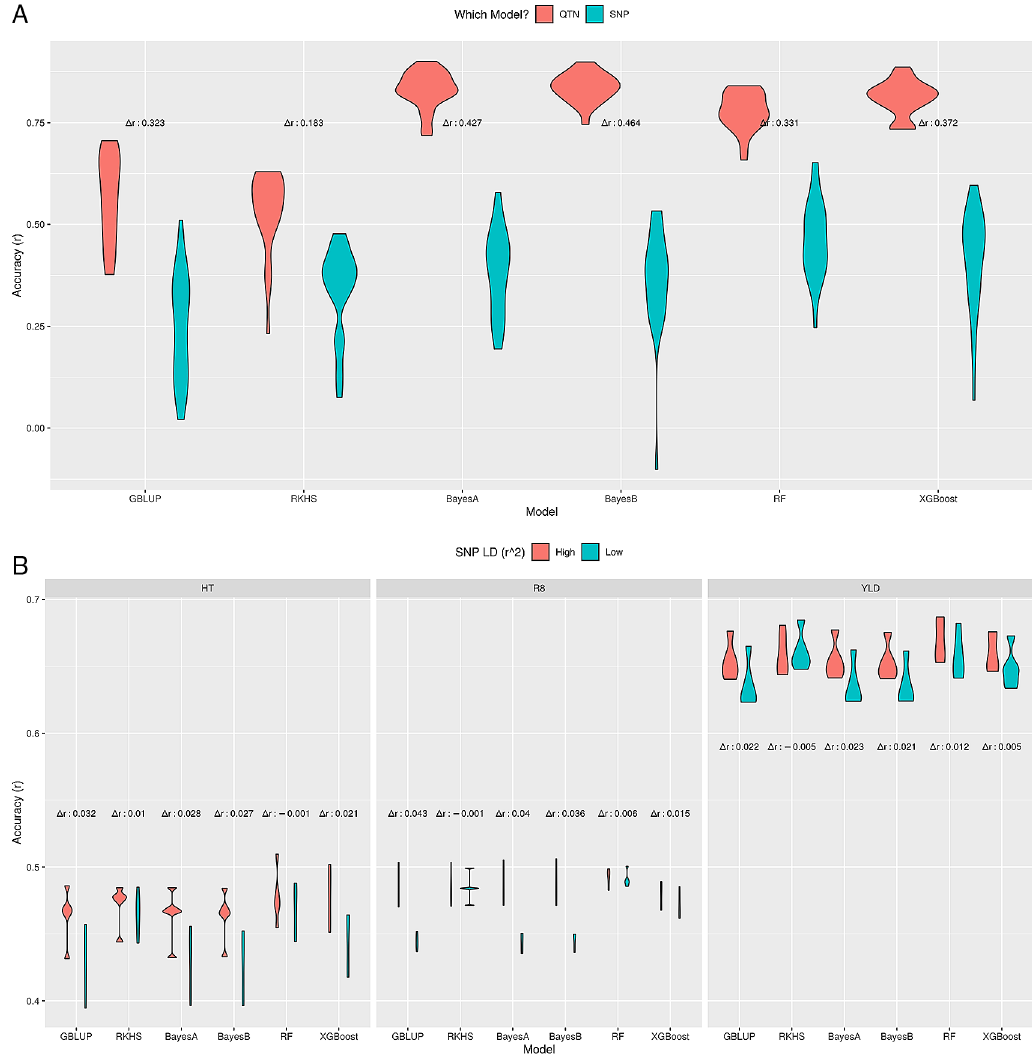
Figure 5. Effect of SNP-QTN LD on prediction accuracy. Prediction accuracy of different GP methods on simulated (A) and real soybean (B) datasets for high and low LD between SNPs and actual QTNs. The difference in median accuracies between these scenarios is indicated as Δ r. A) LD-sim data, low SNP-QTN LD ( r 2 ≤ 0.5). B) LD-soy data, low ( r 2 ≤ 0.5) SNP-QTN LD vs. all SNPs (high In simulations, GP model performance is evaluated based on the difference in prediction accuracies between a model trained on the actual QTNs and a model trained on SNPs in LD (QTN-linked SNPs). Our results show that when SNPs are highly correlated to QTNs (which is likely the case for densely genotyped markers set and r 2 > 0.9), all methods perform equally well and the SNP-based model predictions are very close to those of the actual QTN based models (Extended Data, Figure S8 27 ). On the other hand, for low LD between SNPs and QTNs, there was in general a difference between median prediction accuracies ( Δ r ) of the QTN and SNP-based models (Figure 5A). This difference varied between methods, from 0.18 forRKHS regression to 0.43 – 0.46for the Bayesian methods, with GBLUP and ML methods between these (0.32 – 0.37). The relative robustness of particularly the Random Forest model in these circumstances compared to the Bayesian methods, in combination with its good performance in many simulations, supports its usefulness for GP. As a real genotype and phenotype dataset, we used three Soybean traits, i.e. height, time to R8 developmental stage and yield (LD-soy). The motivation was to choose a low-dimensional real dataset with highly correlated SNPs to understand the impact of SNP-QTL LD only. The complete set of markers (4,235 SNPs) had many correlated SNPs, such that only 261 were left with low LD ( r 2 ≤ 0.5). Here, in contrast to LD-simdata, where we knew the QTNs in advance, we